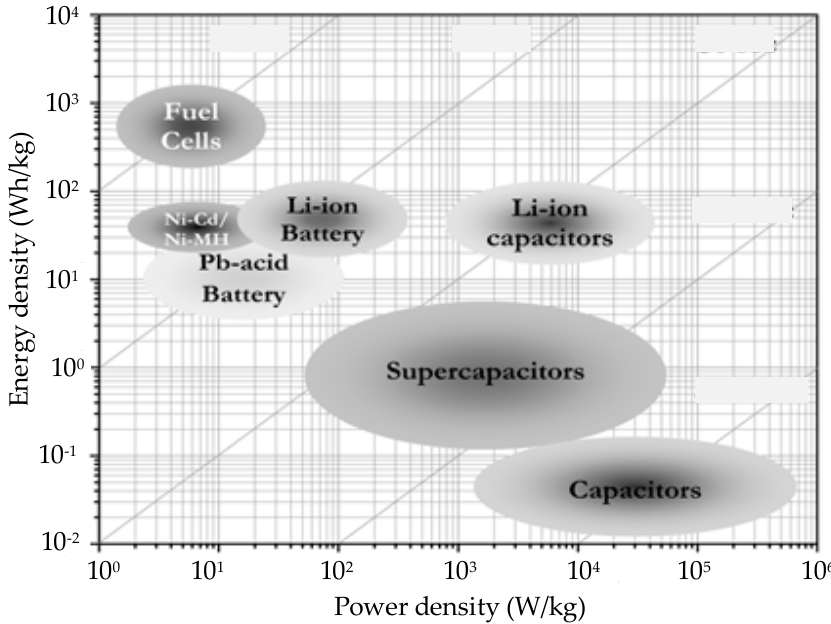
Figure 2. The Ragone plot of some energy storage devices showing their characteristics in regard to their energy and power densities (adapted from [44]).